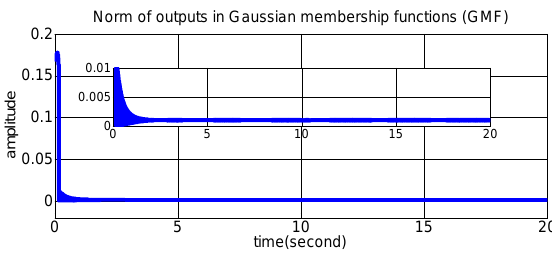
Figure 20. Norm of output of Gaussian membership